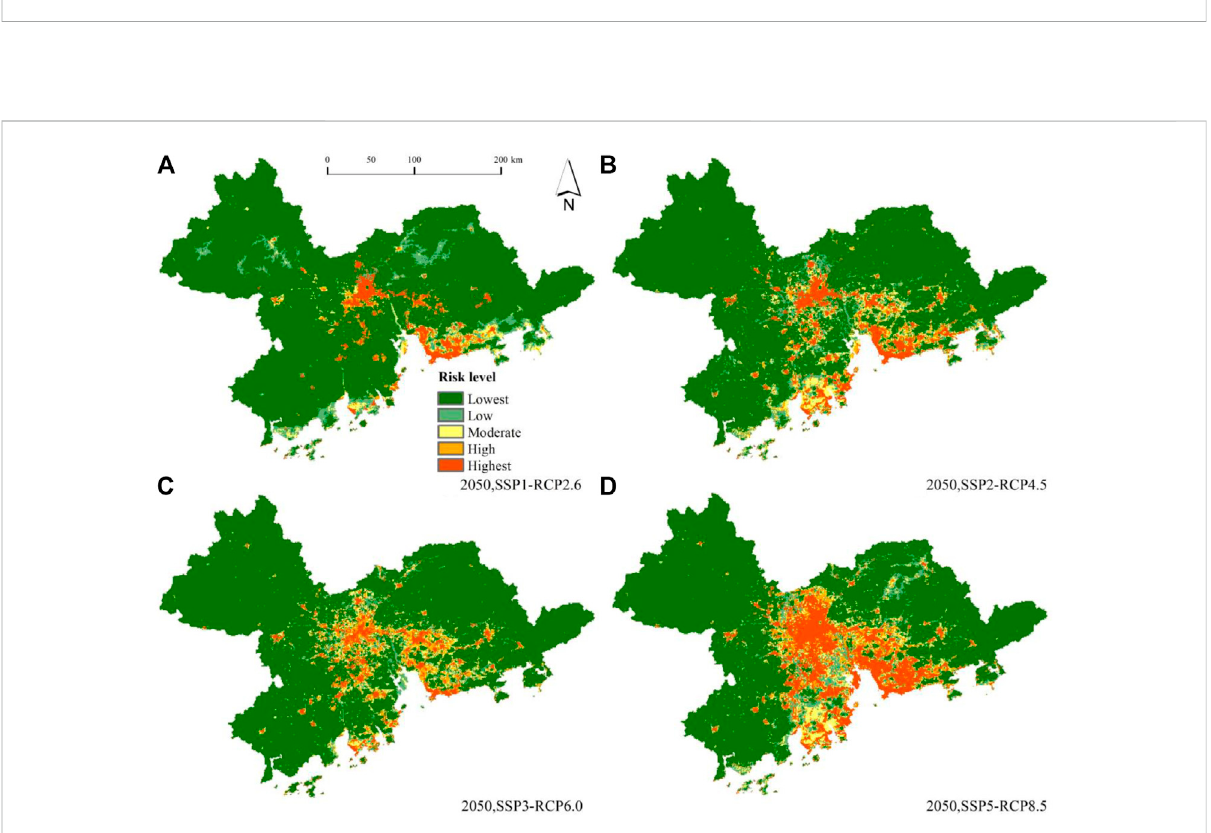
FIGURE 9 Spatial distribution of future fl ooding risk over the PRD under four scenarios in